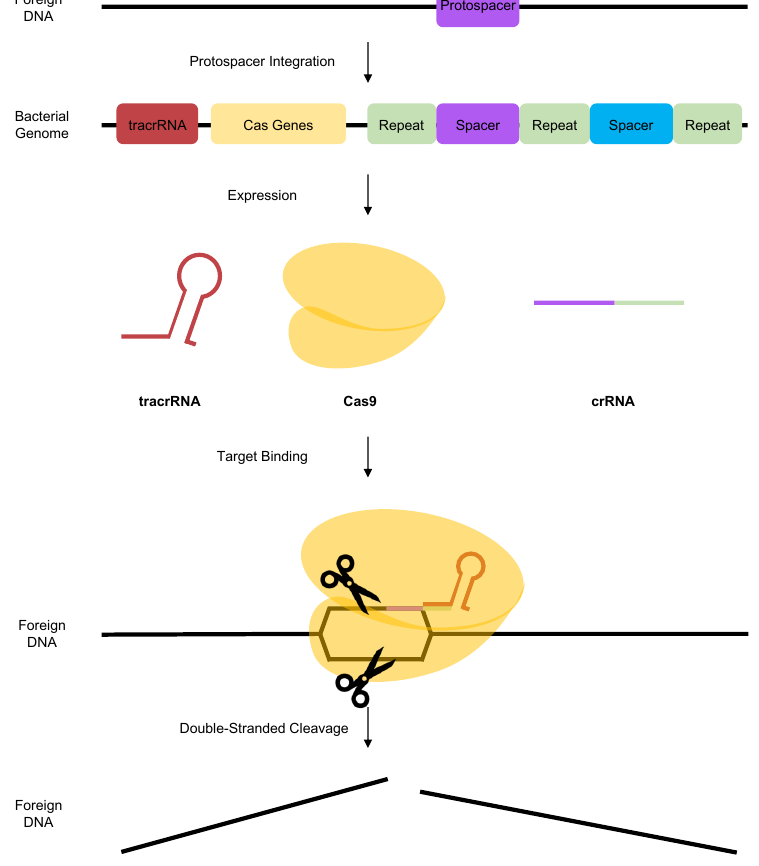
Figure 3. Overview of Type II S. pyogenes clustered regulatory interspaced short palindromic repeats (CRISPR)-Cas System. Shown is a schematic overview of the type II CRISPR system utilized by S. pyogenes . Foreign protospacer DNA from foreign exogenous elements is acquired by Cas9 and integratedintotheCRISPRlociasaspacer. TheCRISPRsystemrecognizesthesameforeignagentwhenit invades the cell again. This allows the transcription and expression of the corresponding trans-activating CRISPR RNA (tracrRNA) and CRISPR RNA (crRNA) along with the Cas9 nuclease. These complex binds to the invading element, guided by tracrRNA and crRNA, and induces double-stranded cleavage of the foreign DNA as an adaptive immune